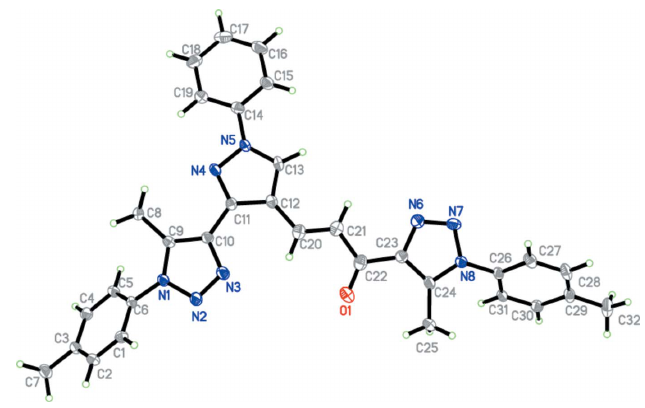
Table 2 Experimental details.